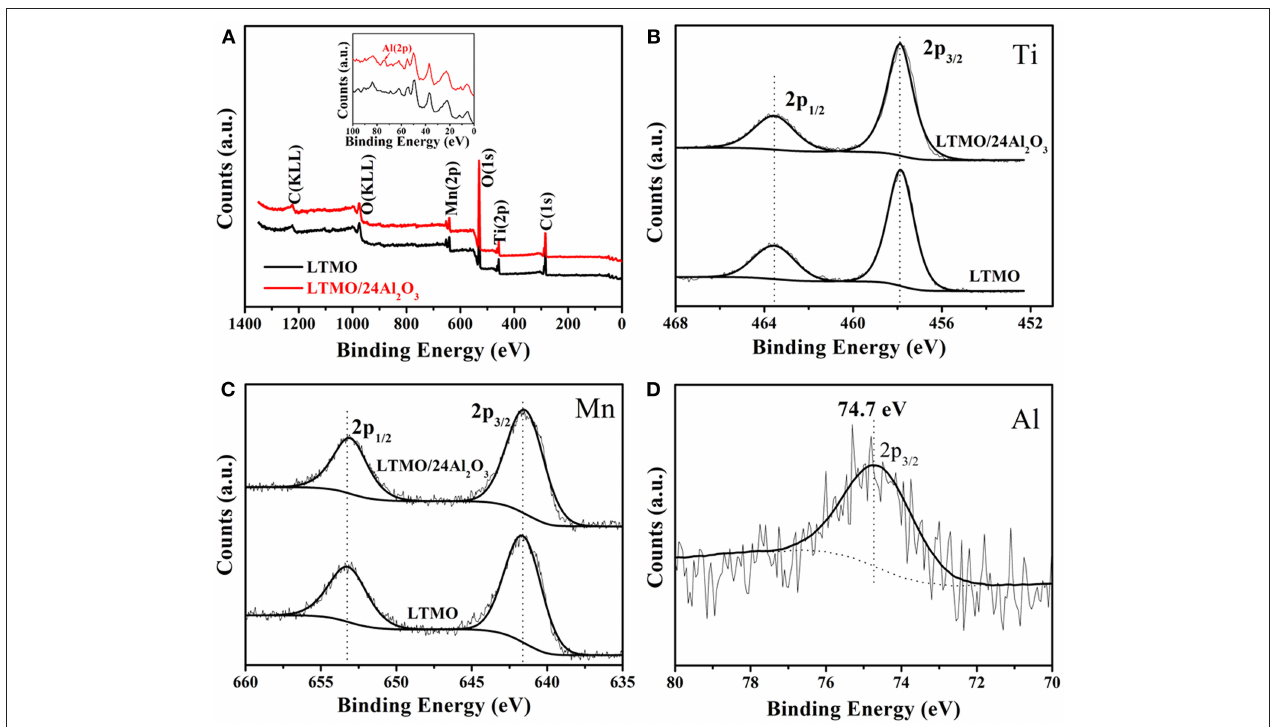
FIGURE 4 | (A) XPS survey spectrum and core level spectra of transition metals of LTMO and LTMO/24Al 2 O 3 : (B) Ti 2p; (C) Mn 2p; (D) Al 2p.